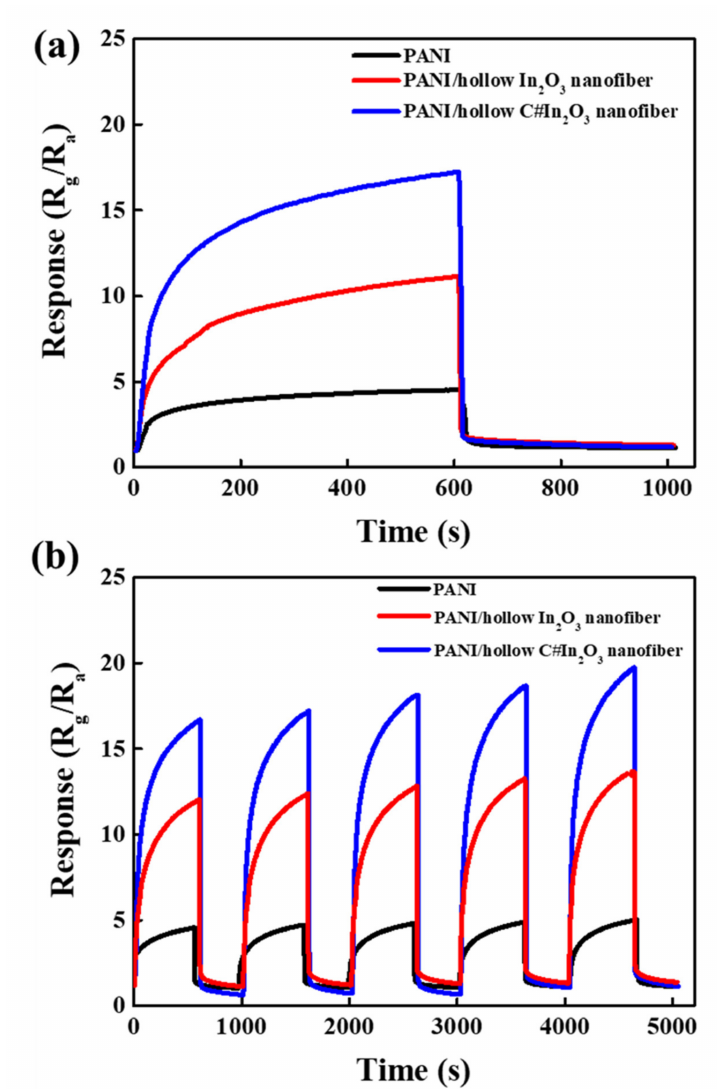
Figure 7. ( a ) The room-temperature response and ( b ) the repeatability and reversibility of PANI, PANI/hollow In 2 O 3 nanofiber, and PANI/hollow C#In 2 O 3 nanofiber composite sensors with expo- sure of 1 ppm NH 3